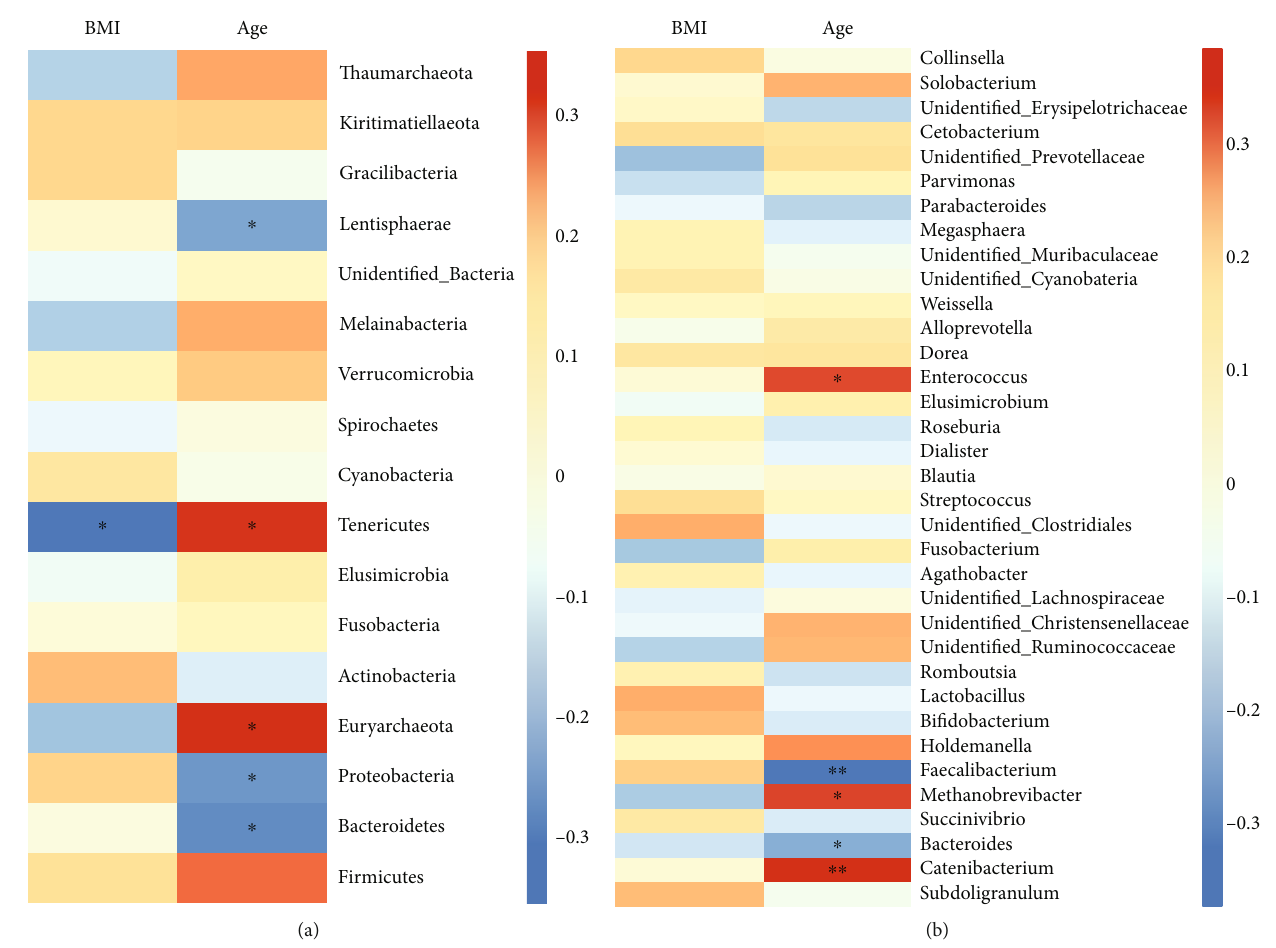
Figure 5: Correlation of age ( n = 48 ) and BMI ( n = 48 ) of the study participants with the relative abundance gut fl ora at both (a) phylum and (b) genus levels. ∗ P < 0 : 05 and ∗∗ P < 0 : 01 . BMI: body mass index; n :